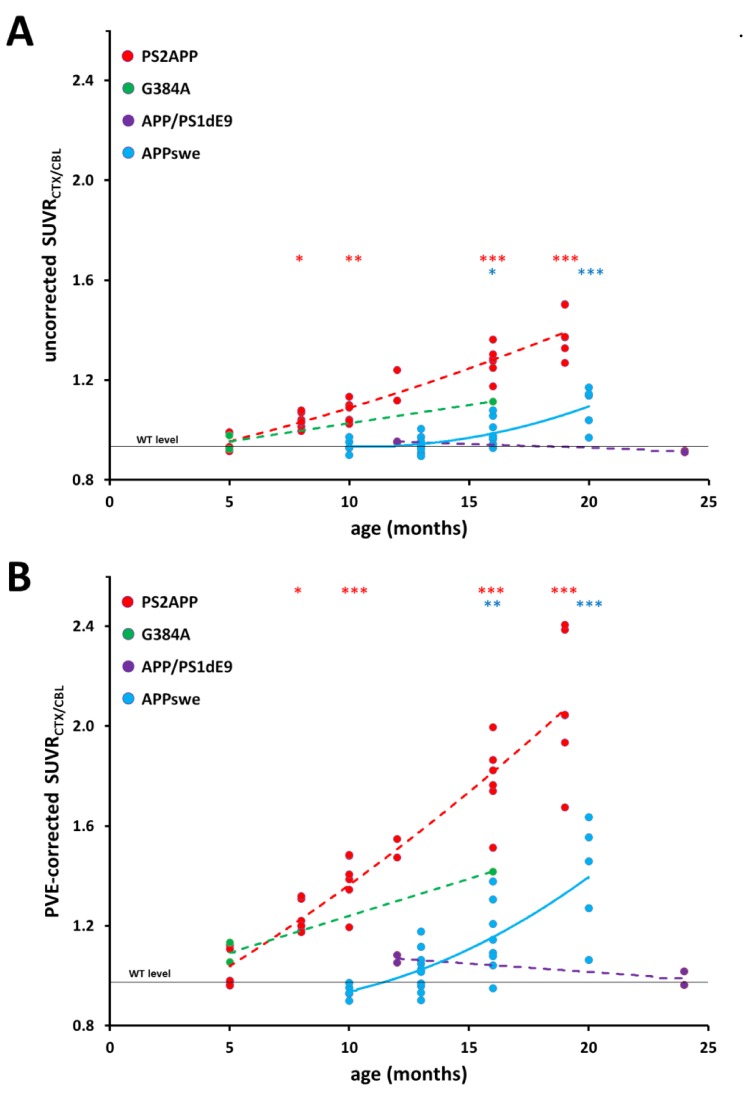
Comparison of uncorrected (A) and PVE-corrected (B) SUVRCTX/CBL of the entire dataset.Dots indicate corresponding assessments of SUVRCTX/CBL in individual mice. Dashed lines express the estimated time dependent progression in PS2APP (red; five months: N = 5; eight months: N = 7; 10 months: N = 6; 12 months: N = 2; 16 months: N = 6, 19 months: N = 6), G384A (green; five months: N = 2; 16 months: N = 1) and APP/PS1dE9 (purple; 12 months: N = 2; 24 months: N = 2) mice, fitted with a polynomial function (for the purposes of illustration). Longitudinal progression in APPswe mice is indicated by a continuous blue line. P-values for one-way ANOVA (incl. post hoc Tukey) testing of PS2APP and APPswe mice versus youngest littermates were as indicated: * p < 0.05; ** p < 0.005; *** p < 0.001.